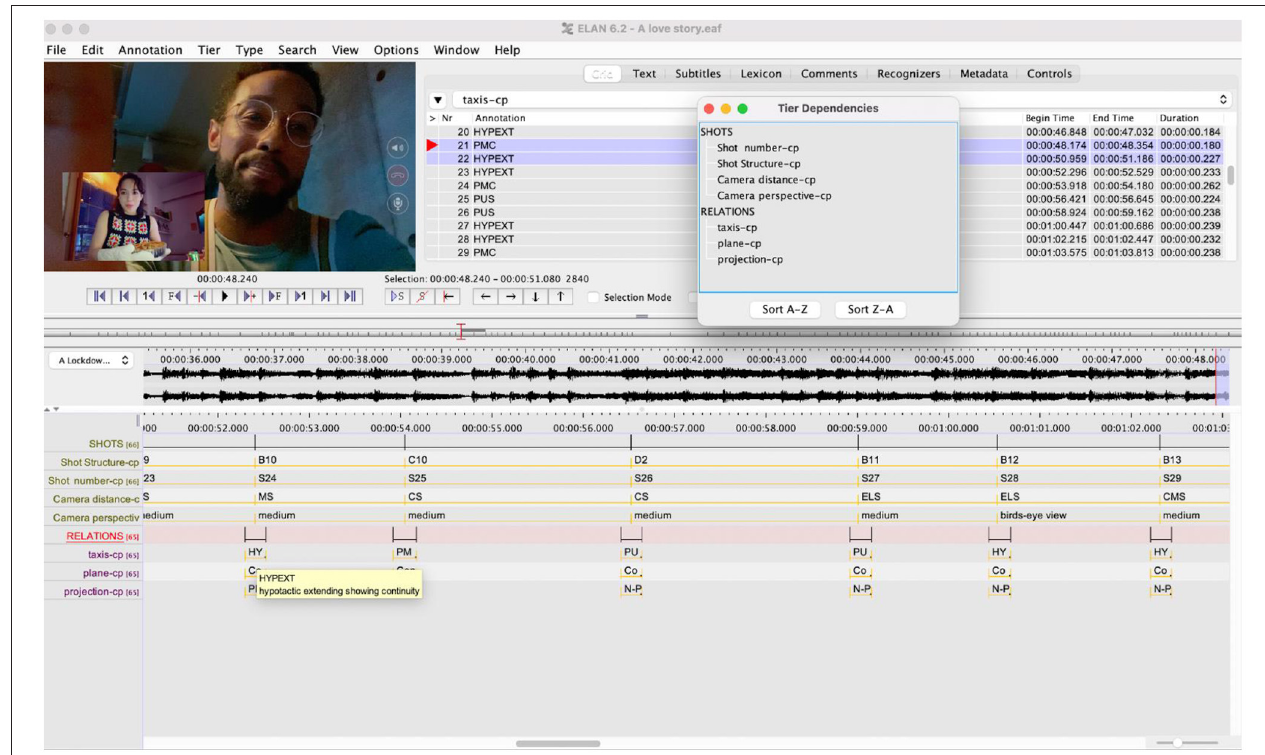
FIGURE 6 | Screenshot of our ELAN template for the analysis of “A Lockdown Story” with the tier dependencies in a separate window 7 .